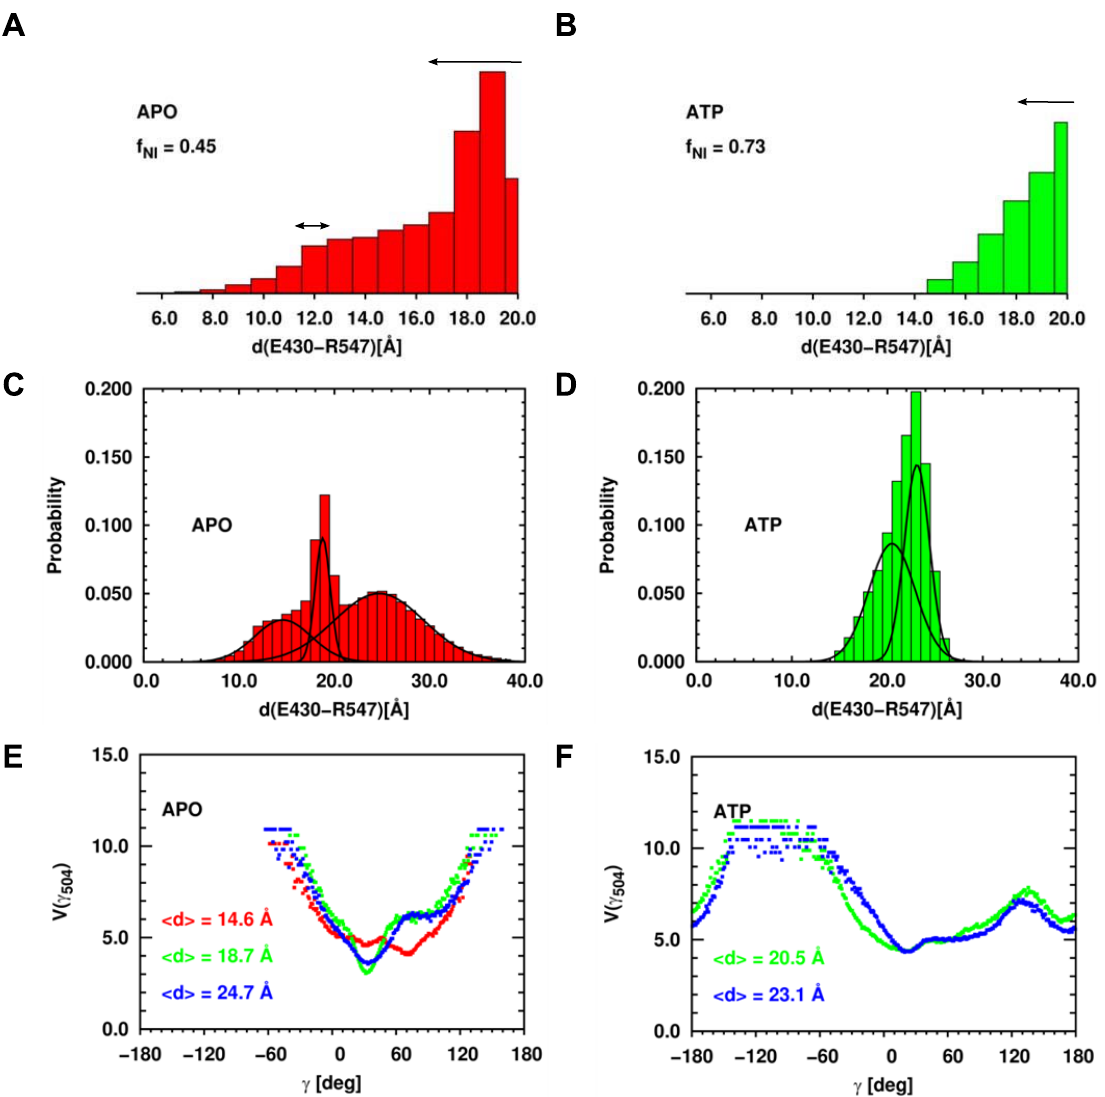
Figure 10. Comparison between MD data and EPR experiments. Histograms of the distance E430-R547 computed from the MD simulations in the APO state (panels A and C, red) and in the ATP-bound state (panels B and D, green). Panels A and B represent the distributions up to 20 A˚, as in the EPR experiments and panels C and D represents the same distributions up to 40 A ˚ . Each subpopulation in the distance distribution was fitted with a Gaussian function shown with black lines. The black arrows in panels A and B represent the experimental results from Ref. [81]. FEP V( c 504 ) computed from different subpopulations relative to the distance E430/R547 distribution function in the APO state (panel E) and in the ATP state (panel F). , d . represents the mean value of the Gaussian distributions shown in panel C for the APO-DnaK and D for the